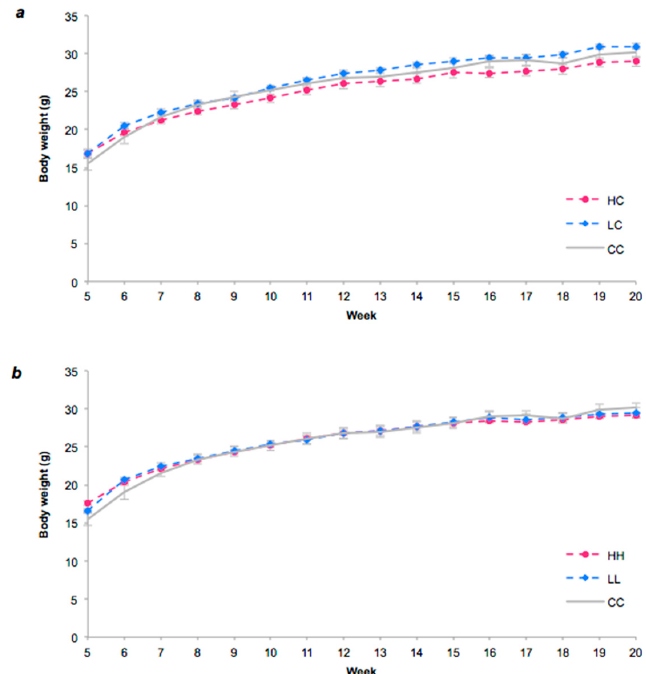
Figure 2. Body weight was measured weekly from weaning in offspring fed five different diets. Figure 2( a ). CC ( n = 13) denotes the group whose mothers received chow (C) throughout pregnancy and lactation and continued on chow from weaning to 20 weeks. HC ( n = 13) denotes offspring whose mothers received the high GI diet (H) and were switched to chow from weaning onwards. LC ( n = 14) denotes offspring whose mothers received the low GI diet (L) but were switched to chow from weaning onwards. Figure 2( b ). HH ( n = 15) denotes offspring whose mothers received the high GI diet and remained on the high GI from weaning onwards. LL ( n = 10) denotes offspring whose mothers received the low GI diet and continued on the low GI diet from weaing onwards. Data are expressed as the Mean ± SEM. There were no significant differences except at week 16 in HC vs.